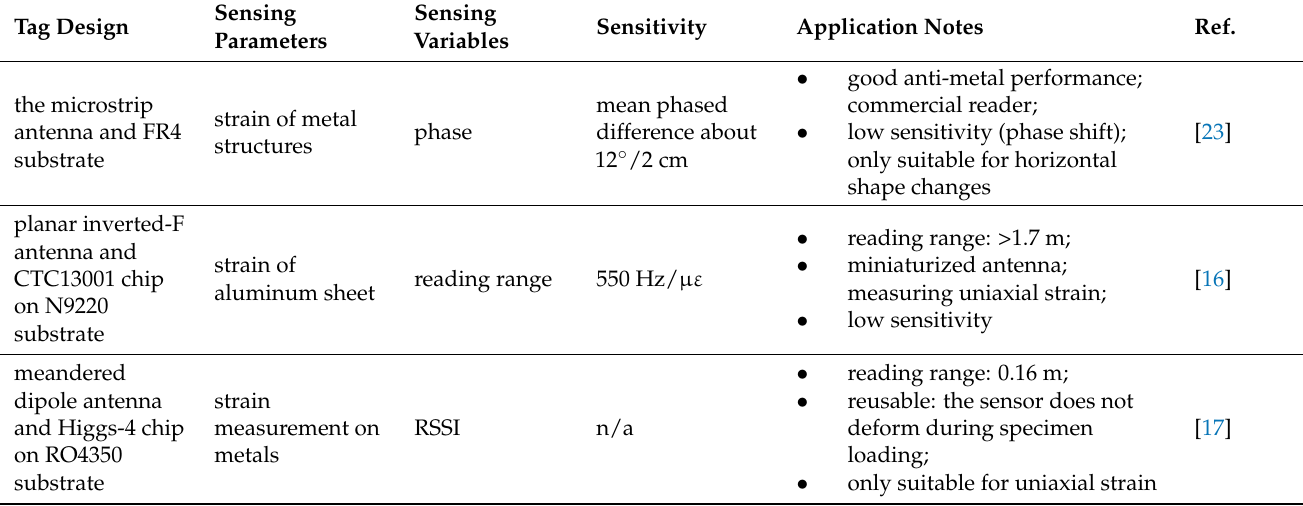
Table 4. Antenna-based RFID sensor tags for SHM.